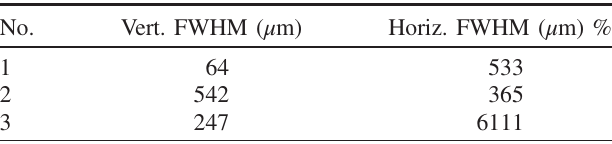
TABLE II. Beam sizes (FWHM) at the target location as measured with the wire scanner. Beam configuration No.